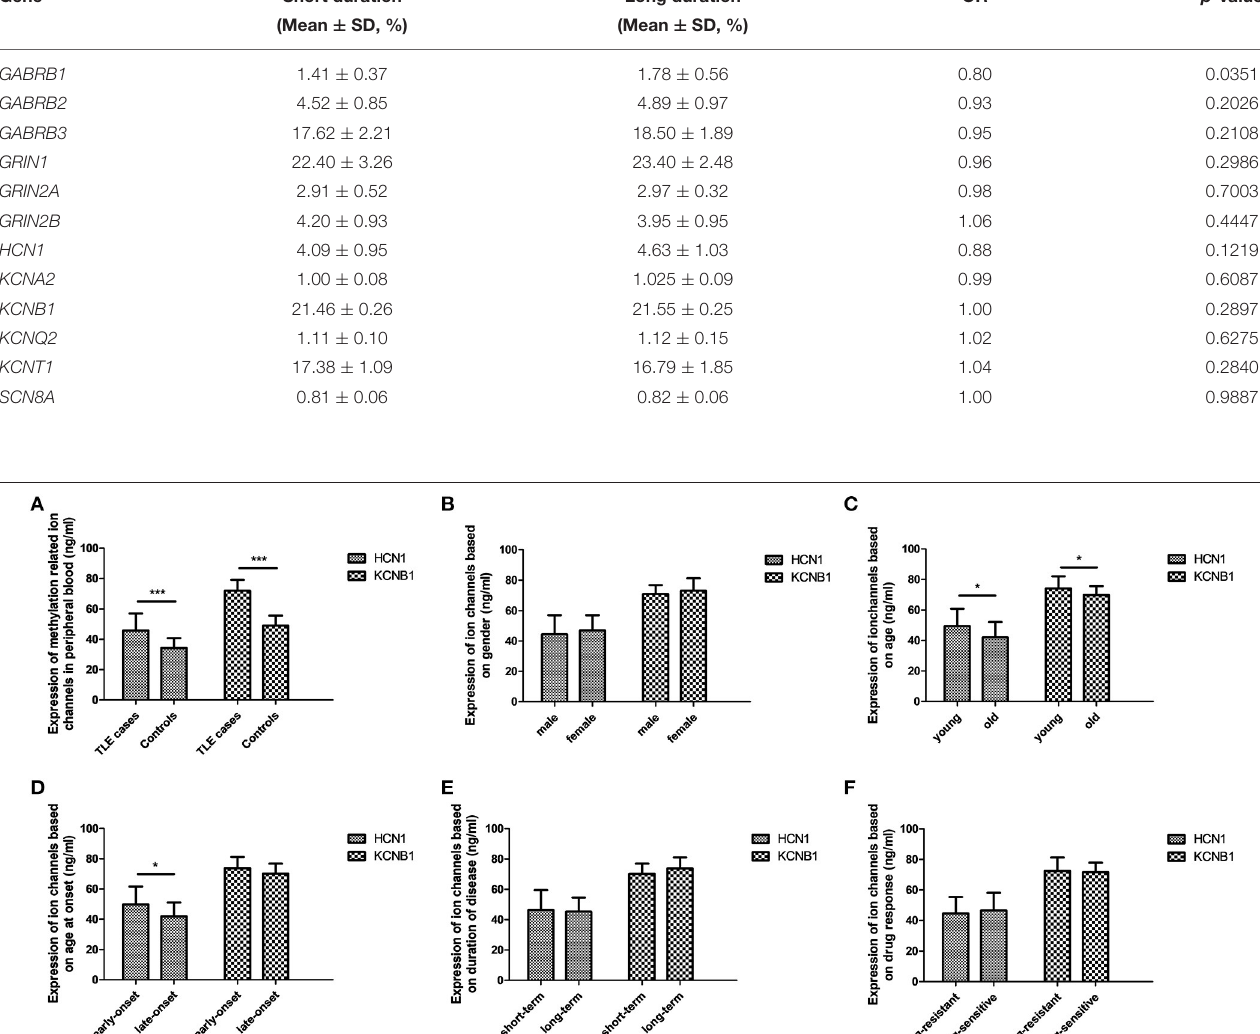
TABLE 6 | DNA methylation of 12 ion-channel genes between short and long duration of disease. Gene Short duration Long duration OR p -value